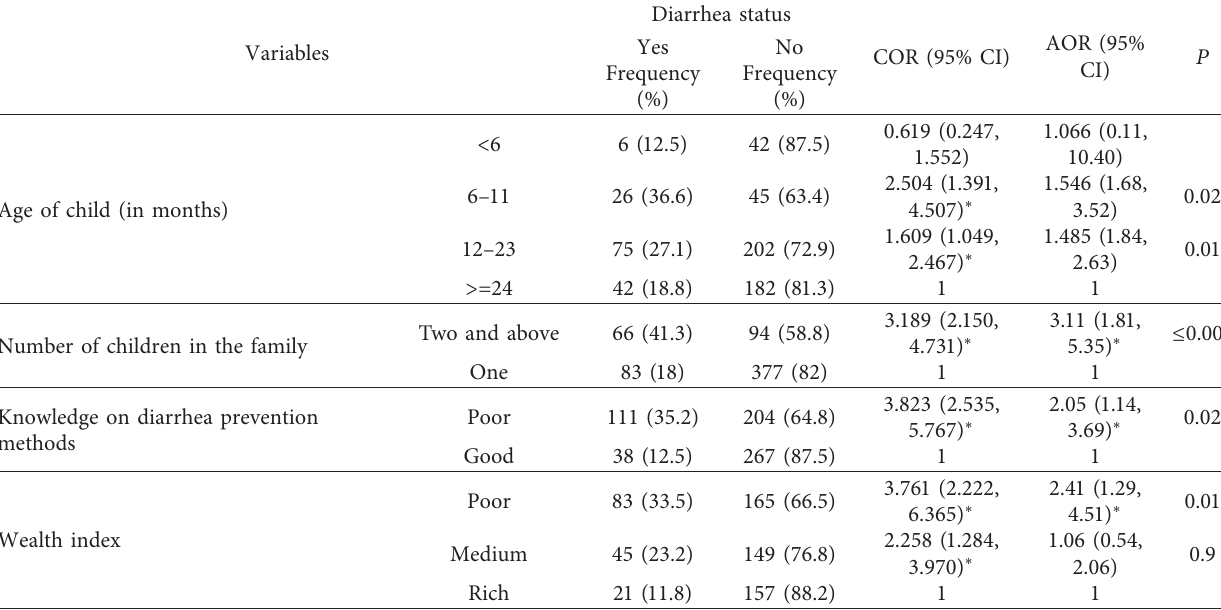
Table 3: Bivariable and multivariable logistic regressions of factors associated with diarrhea among under-five children in Horo Guduru Wollega Zone, Oromia Region, Western Ethiopia, from February 15 to March 10,